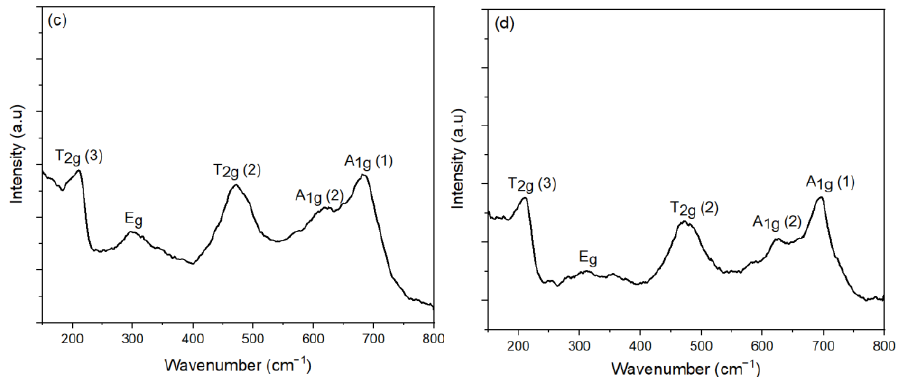
Figure 12. Raman spectra of the sample prepared with ( a ) 0 M, ( b ) 0.05 M, ( c ) 0.1 M, and ( d ) 1 M oleic acid concentration.